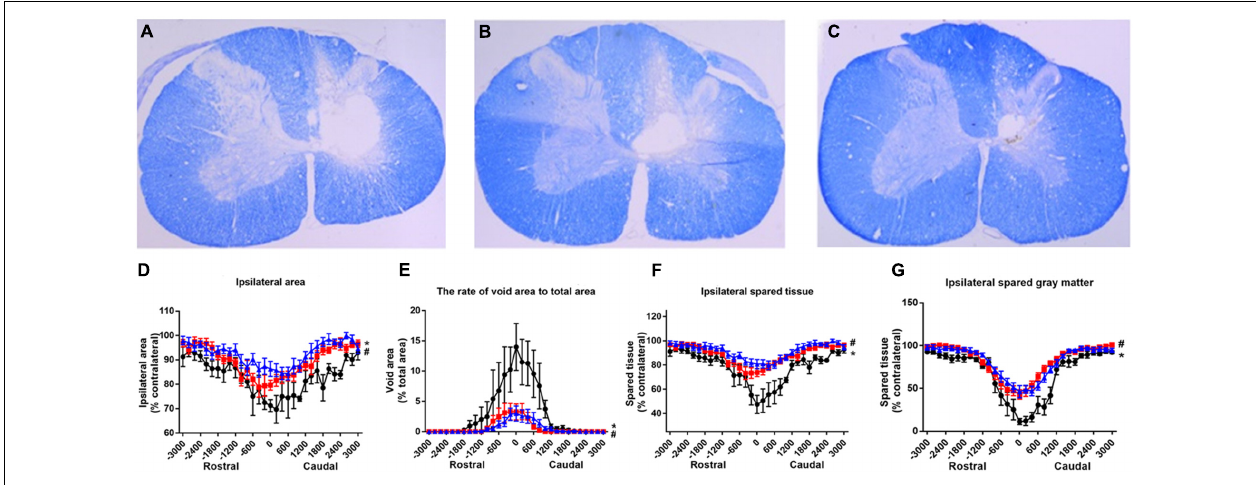
FIGURE 9 | EC staining results. (A) Epicenter of injury group; (B) epicenter of T50 group; (C) epicenter of T100 group; (D) percentage of ipsilateral side area relative to contralateral side; (E) the percentage of void area relative to total spinal cord area; (F) percentage of ipsilateral spared parenchyma relative to the total area of contralateral side; (G) percentage of ipsilateral side gray matter relative to contralateral side gray matter. * P < 0.05, comparison between T50 group and injury group; # P < 0.05, comparison between T100 group and injury group.